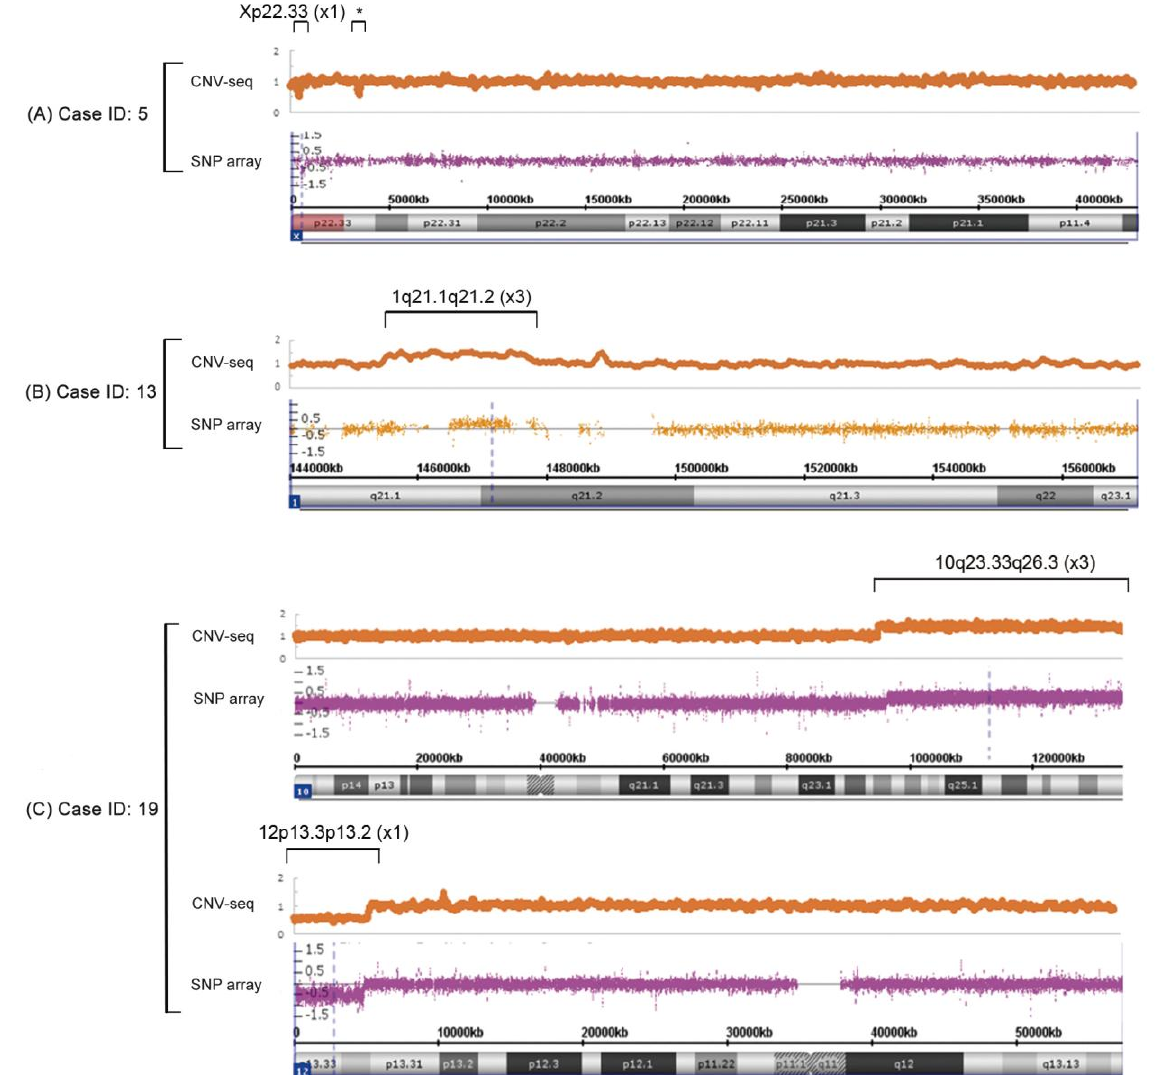
Figure 1. Comparison of CNVs detected by CNV-seq and SNP array. ( A ) In case #5, a deletion at Xp22.33 ( × 1) was detected by both CNV-seq and SNP array. * Another likely benign copy number variation Xp22.33 ( × 1) was also detected in this region by CNV-seq, and the length was about 125 kb. This variant was not detected by SNP array, probably due to the lack of SNP probes in this region. ( B ) Prenatal case #13 had a duplication at 1q21.1q21.2 ( × 3). The size detected by